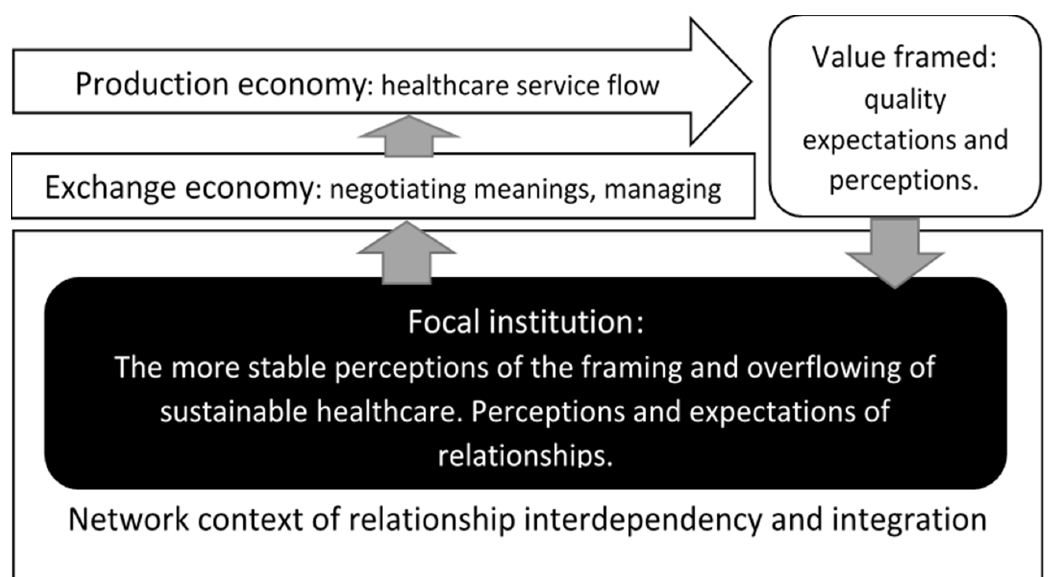
Figure 6. Conceptual model of dynamically managing healthcare service provision.